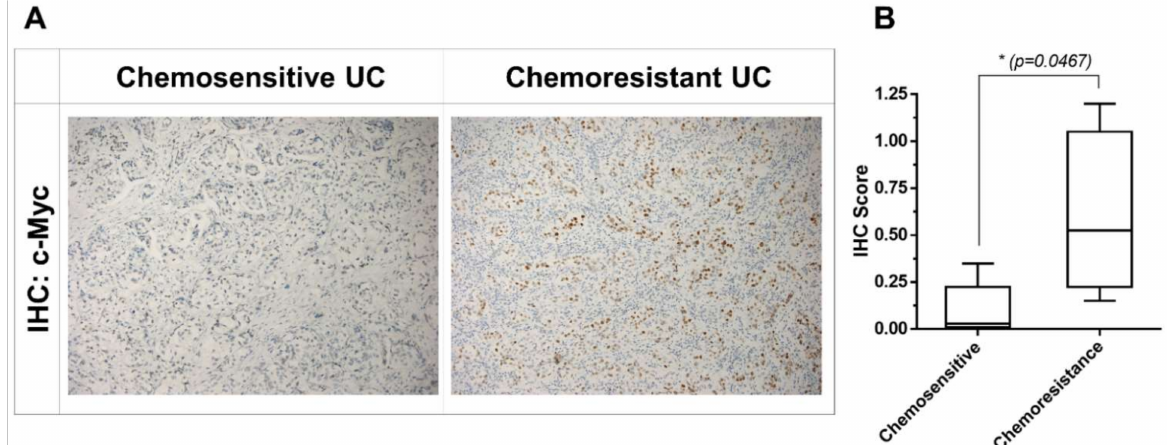
Figure 5. Immunohistochemical staining of c-Myc in tumor tissues obtained from patients with chemosensitive and chemoresistant metastatic bladder urothelial carcinoma. ( A ) Five chemosensitive and four chemoresistant clinical tumor samples were IHC-stained with c-Myc antibodies. The tissue sections were photographed at 100 × magnification. ( B ) IHC scores of c-Myc expression from chemoresistant and chemosensitive tumors. Data were analyzed using unpaired two-tailed Student’s t -test, and values are presented as means ± standard deviation; * p < 0.05 represents a significant difference between the indicated